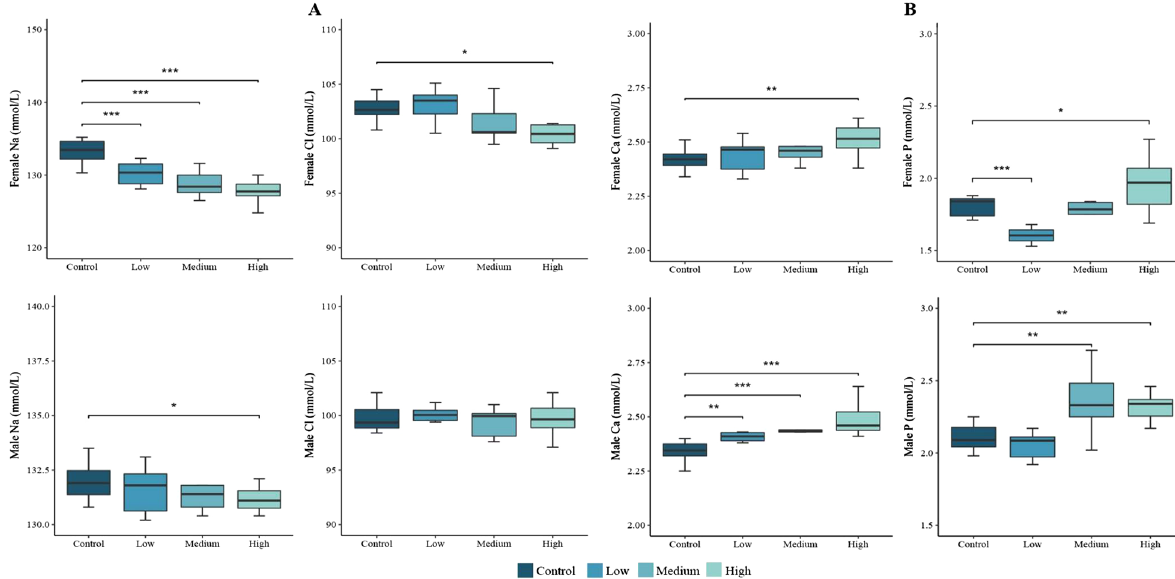
Fig. 3 Changes in blood electrolytes in rats exposed for 90 days to different doses of the maleic acid polymer scale inhibitor. A Changes in Na and Cl. B Changes in Ca and P. All values are expressed as the mean SD per group ( n 20, 10 male and 10 female). The Shapiro–Wilk test was used ± = to assess normality, and Bartlett’s test was used to assess homogeneity of variance. Dunnett’s test was used in the case of homoscedasticity and a normal distribution, and the Wilcoxon rank–sum test was used in the case of heteroscedasticity or a skewed distribution for statistical analysis comparing with the control group. Significance was determined at p < 0.001***, p < 0.01** and p <